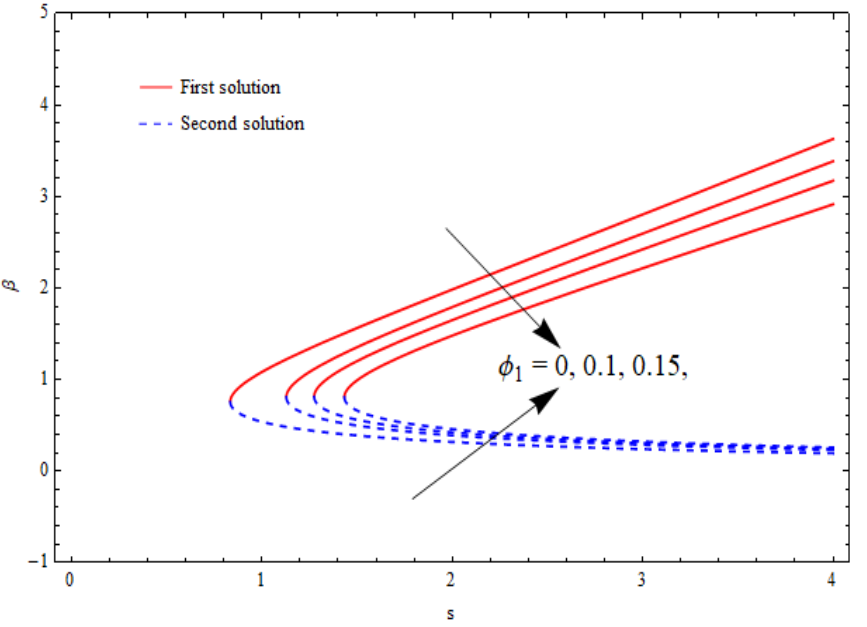
 Figure 5. The solution domain β against mass suction parameter s for distinct ϕ 1 when λ = − 1.5, Figure 5. The solution domain against mass suction parameter s for distinct  k 1 = 1 = γ , δ = − 1, ϕ 2 = Figure 5. The solution domain against mass suction parameter s for distinct